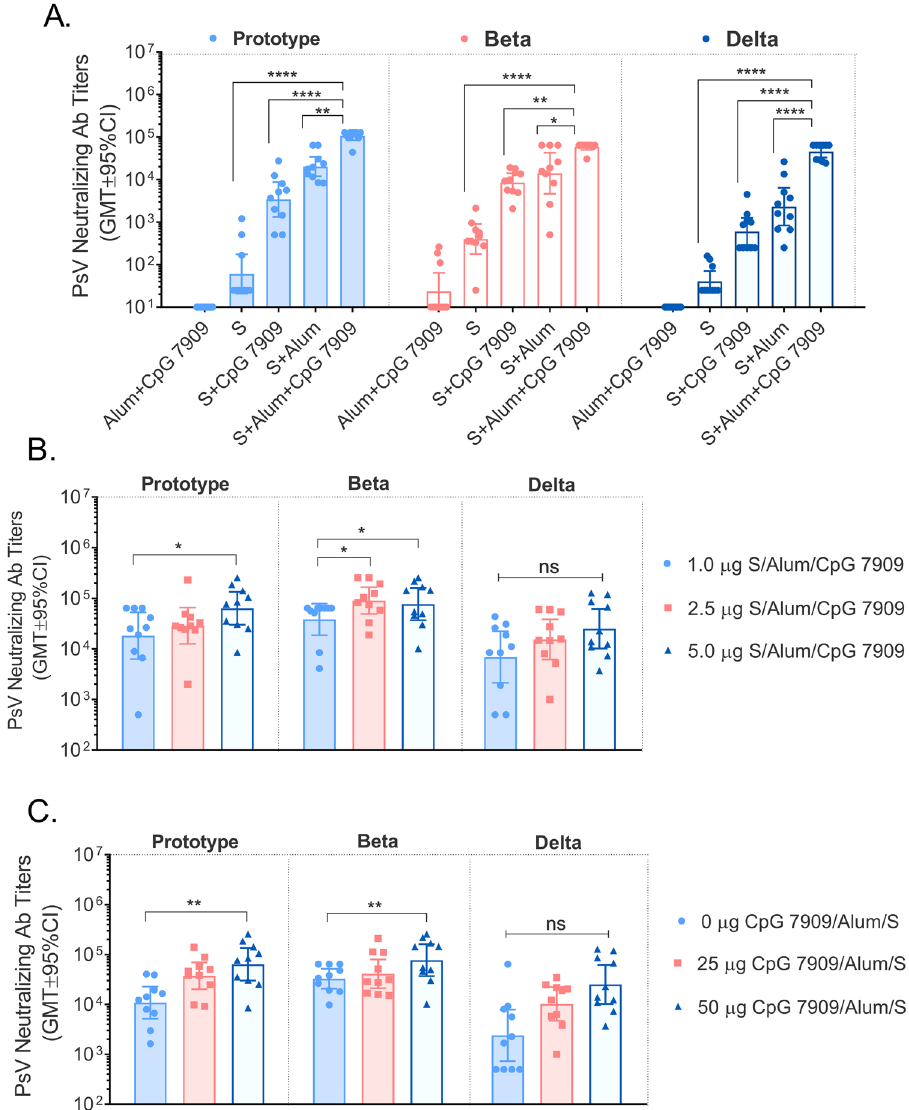
Fig. 3 Variant vaccine-induced serum PsV neutralizing Ab titers in BALB/c mice. A Comparison of 5.0 μ g S protein with different adjuvants (50 μ g AH, 50 μ g CpG 7909 or 50 μ g AH plus 50 μ g CpG 7909/each) in BALB/c mice. B Comparison of different antigen doses (1.0 μ g, 2.5 μ g or 5.0 μ g S protein adjuvanted with 50 μ g AH plus 50 μ g CpG 7909/each). C Comparison of different CpG 7909 adjuvant doses (5.0 μ g S protein adjuvanted with 50 μ g AH plus 0 μ g, 25 μ g or 50 μ g CpG 7909/each). Data are shown as the GMT ± 95%CI. * p < 0.5, ** p < 0.01, *** p < 0.001, **** p <